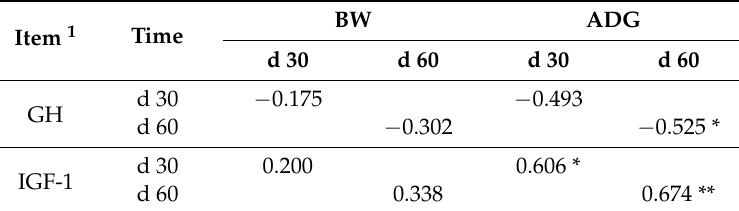
Table 4. Pearson correlation coefficient between serum hormone levels and growth performance on day 30 and day 60 in